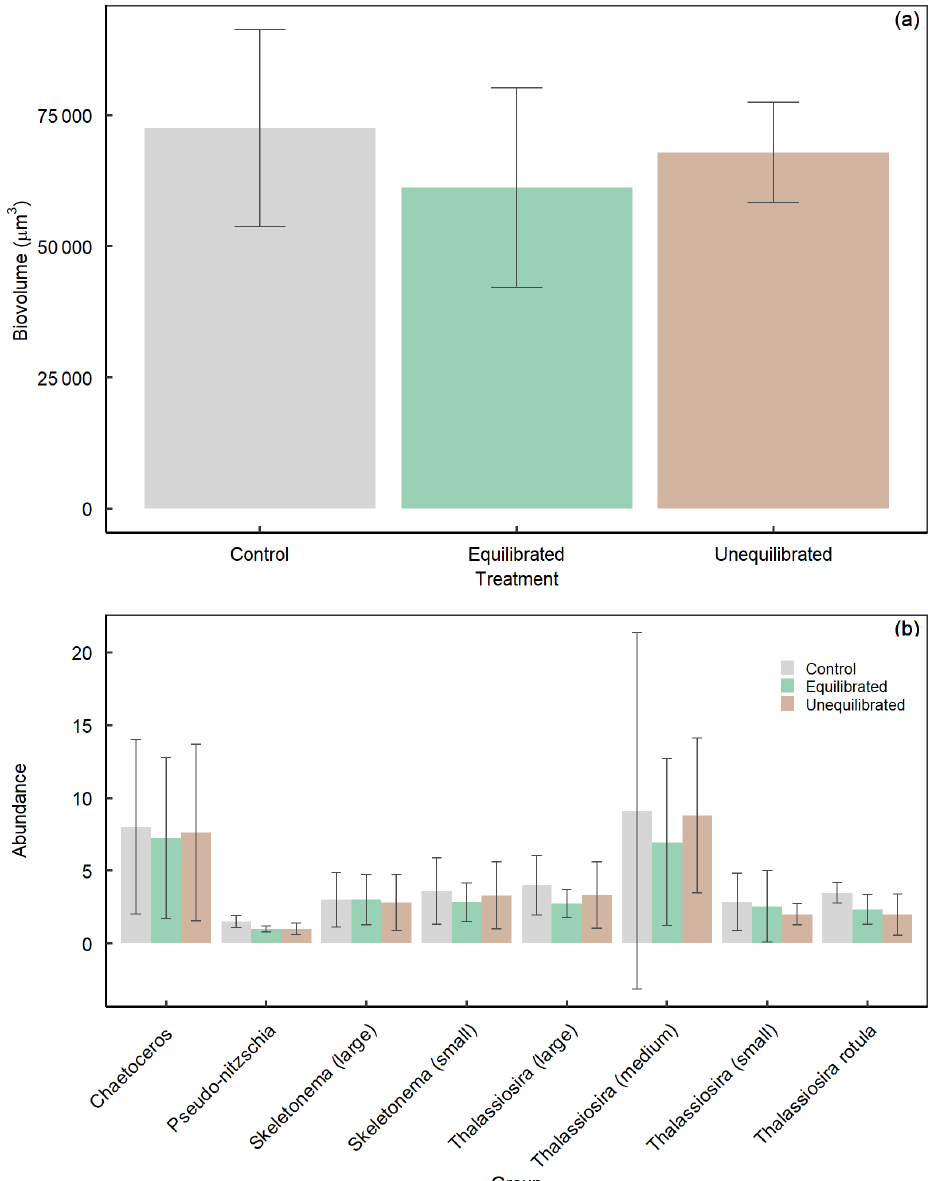
Figure A5. Average diatom (a) biovolume and (b) abundance, during the peak bloom (day 6) within treatments determined via SEM. Data are presented as mean values ±